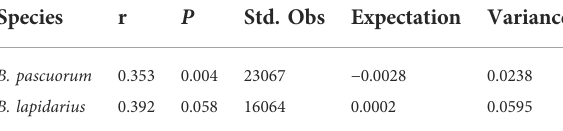
TABLE 5 Mantel test results for both species, comparing geographic distance (Haversine distance in km) against genetic distance ( F ST calculated by